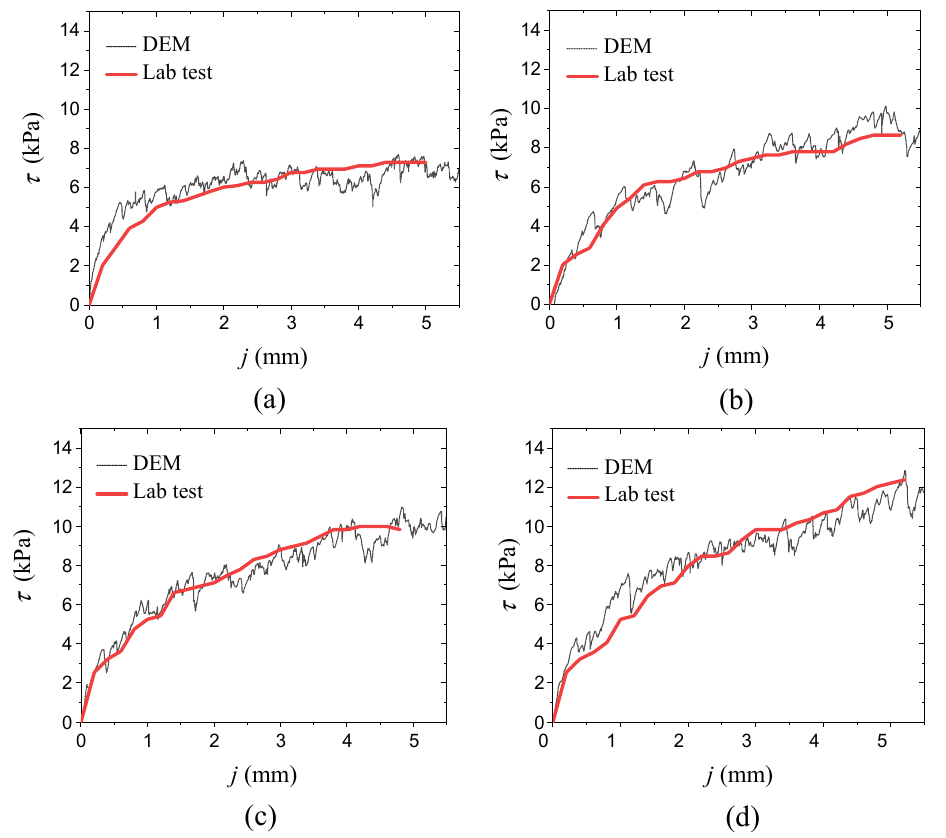
Figure 5. Numerical simulation curve and laboratory test curve: ( a ) σ = 25 kPa; ( b ) σ = 50 kPa; ( c ) σ = 75 kPa; ( d ) σ = 100 kPa. Table 1. Mesoscopic parameter values of DEM under different vertical stress.